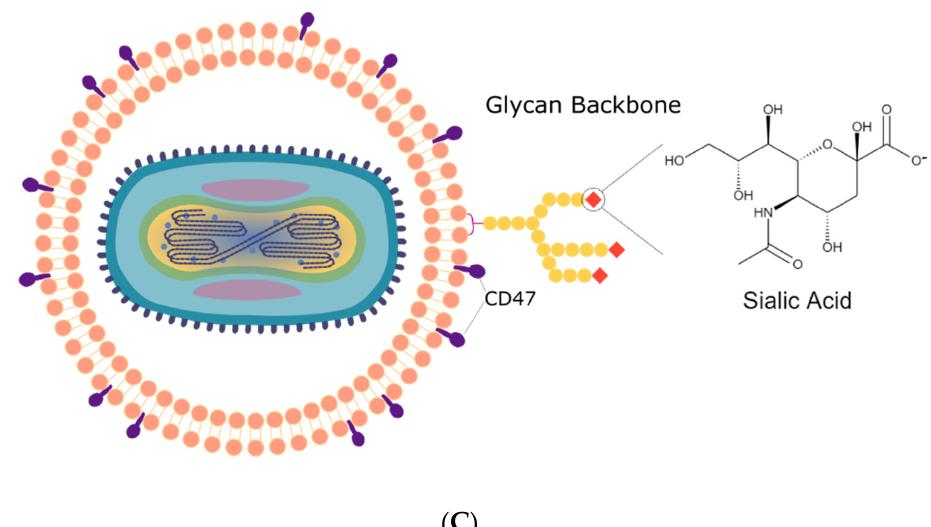
Figure 1. ( A ) Picture of an assembled extrusion system involving an inlet syringe, a membrane holder, and a product syringe. ( B ) Schematic of the extrusion process: oVV, which contains a mix of the unenveloped intracellular mature vaccinia (IMV) and extracellular enveloped vaccinia (EEV), and EDM is loaded on the left and, through the extrusion, emerged as EDM-coated oVV or EEV on the right. ( C ) Depiction of the EDM coating, notably with sialic acid residues decorating its surface.